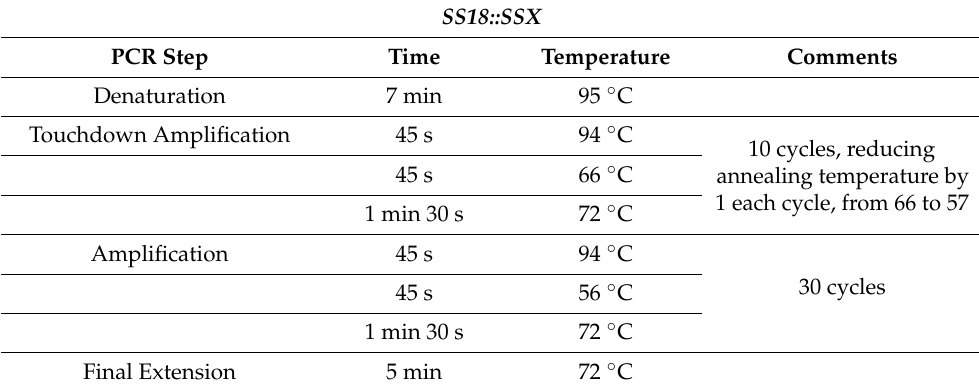
Table 2. Thermocycler conditions for SS18::SSX .